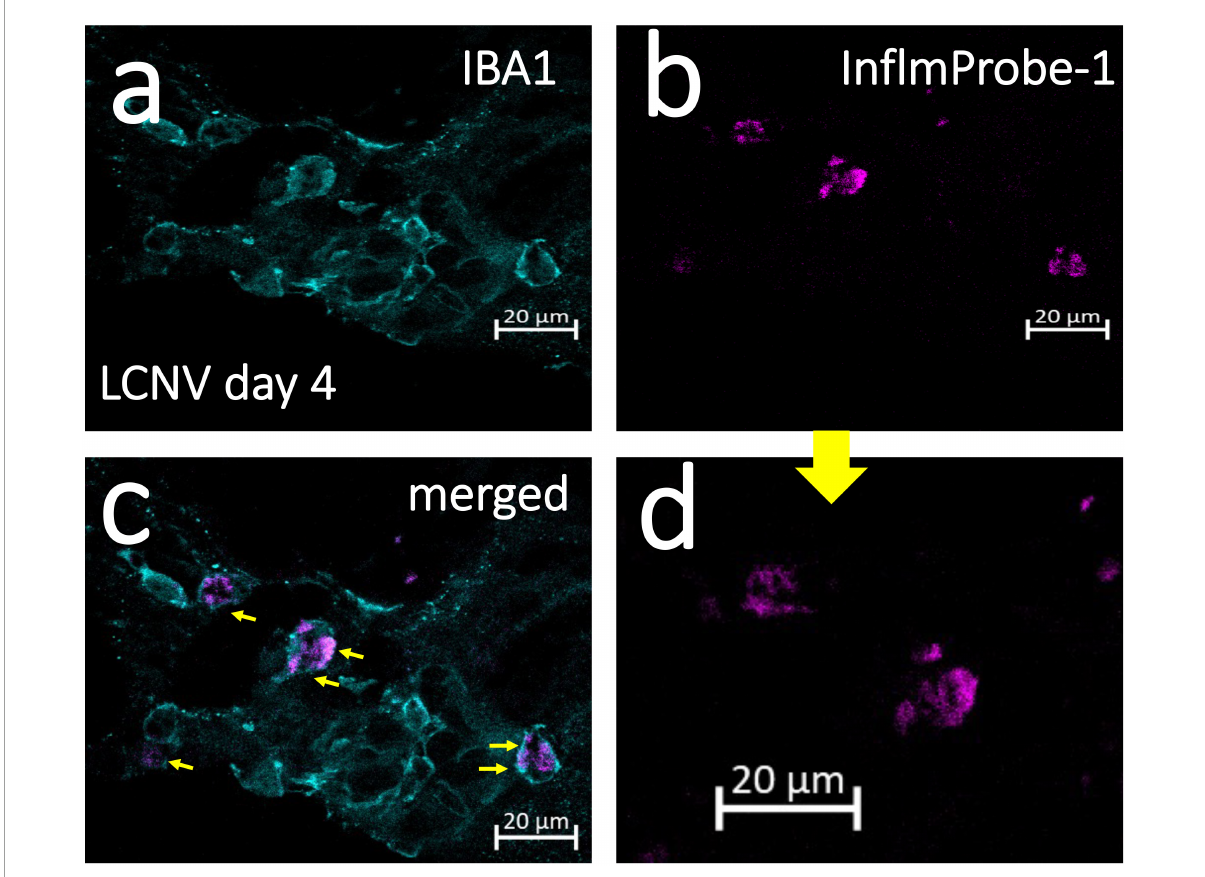
FIGURE5 Confocal imaging of NLRP3 in laser induced choroidal neovascularization (LCNV) tissues using InflammaProbe-1. Four days after LCNV, mice were intraperitoneally injected with InflammaProbe-1 at 10 mg/kg and enucleated after 6 h. Their choroids were dissected and co-stained with fluorescently tagged antibodies against IBA1, which targets macrophages. The stained choroidal lesions were then imaged with confocal fluorescence microscopy at 63x magnification (a–c) . (d) Higher magnification of panel (b) . The yellow arrows in panel (c) indicate InflammaProbe-1 localization in macrophages. These are representative confocal images taken from 12 choroids. See also Supplementary Figure 4 for co-localization of InflammaProbe-1 in 3D reconstructed LCNV lesions from confocal